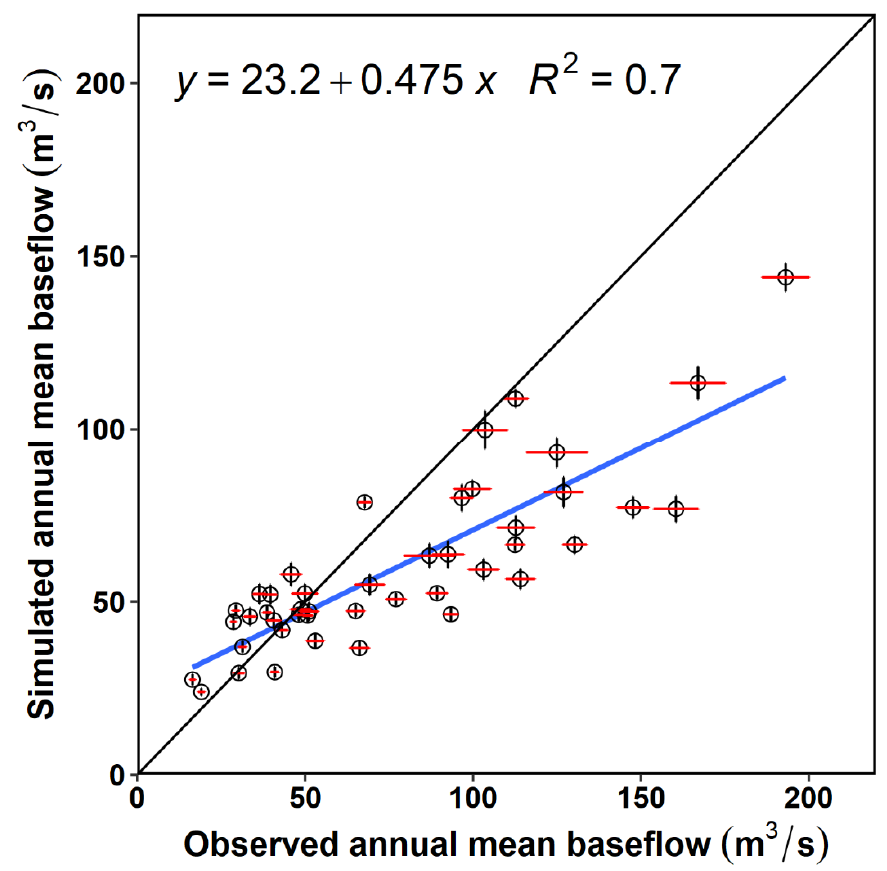
Figure 4. Relationship between the simulated and observed annual mean baseflow in the historical period. The black and red error bars represent standard errors in simulated and observed annual total baseflow. The black line is the 1:1 line.